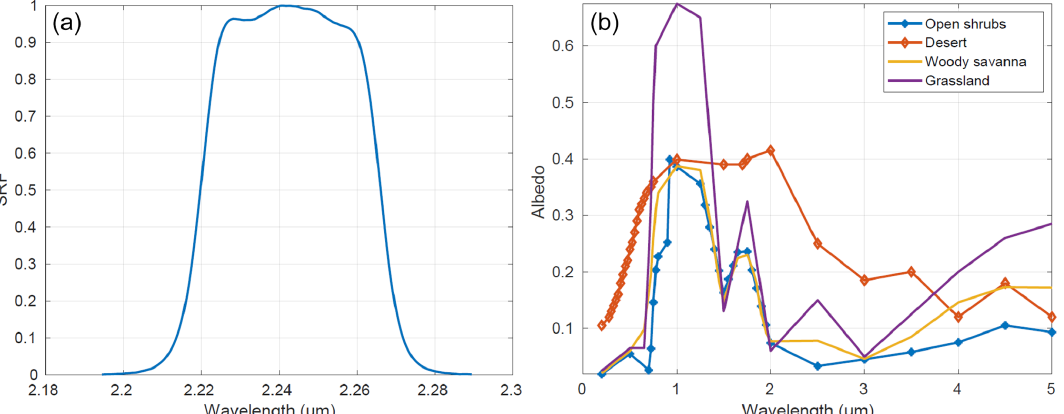
Figure 15. (a) Sensor response function for ABI channel 6; (a) spectral albedo for desert and open shrubs. The desert albedo value is much higher than open shrubs at